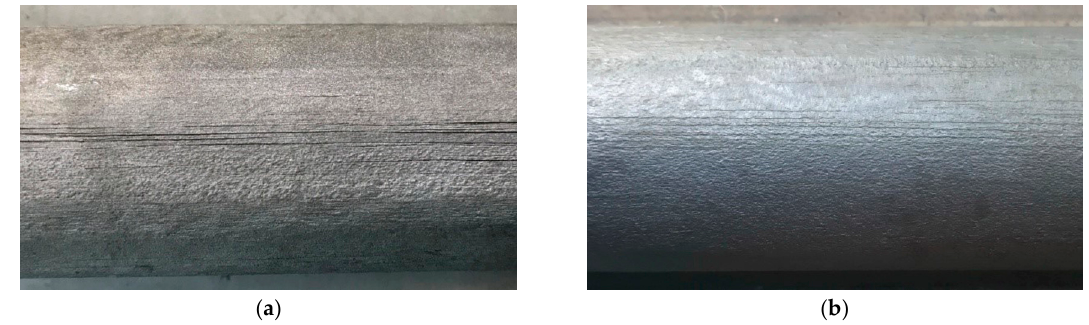
Figure 15. The comparison of surface wrinkle defects before and after optimization of process parameters. ( a ) Before optimization of process parameters. ( b ) After optimization of process parameters.